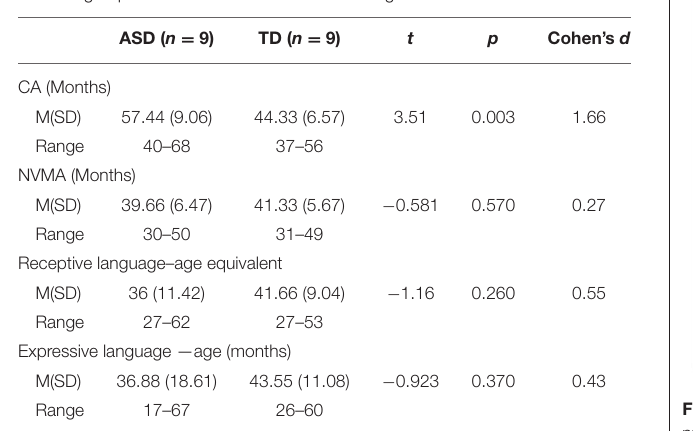
TABLE 2 | Descriptive statistics of typically developing and autism spectrum disorder groups matched on non-verbal mental age.